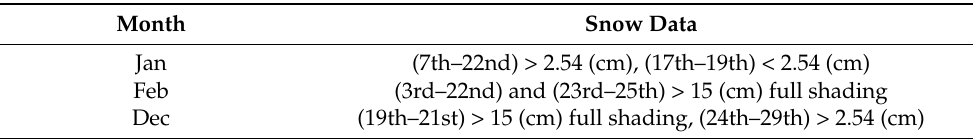
Table 6. PV shadings information for the case study